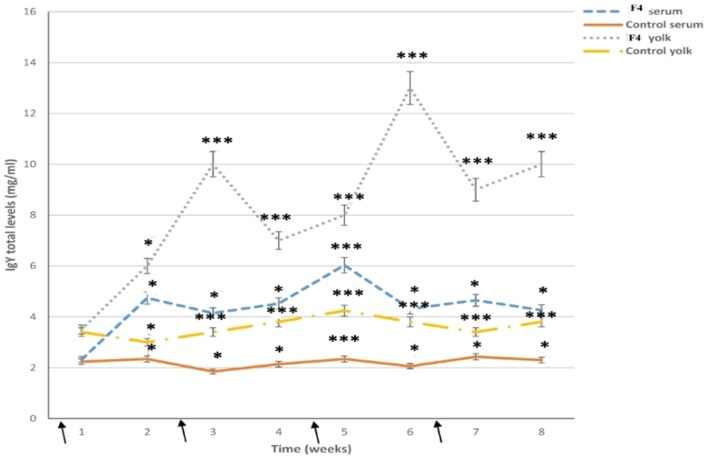
Total immunoglobulin levels. Serum and yolk levels of total immunoglobulin Y (IgY) in both the F4 and Control groups from 23 to 42 weeks *P < 0.05, ***P < 0.001. Arrows indicate immunizations